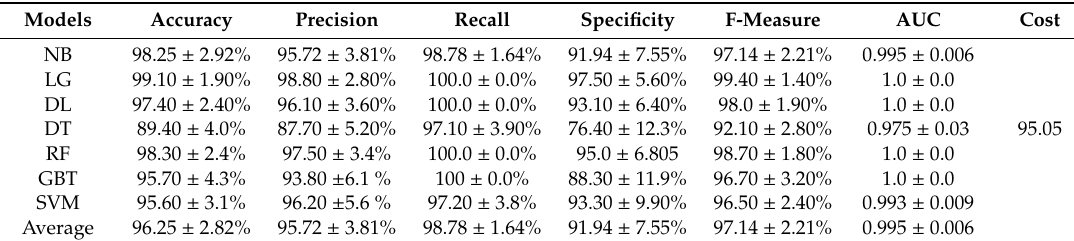
Table 10. Ensemble-1 results based on selected